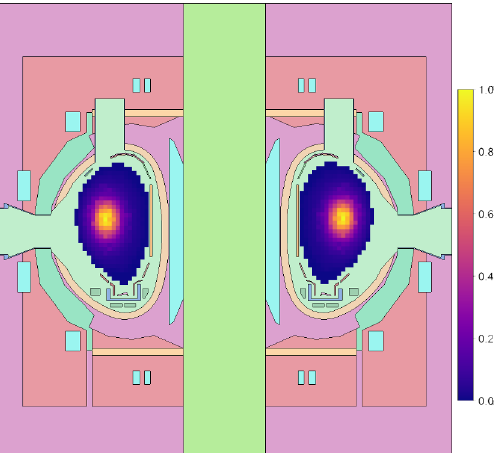
Figure 2: Sectional view of a realistic D shaped neutron source used for comparison between MCNP and Serpent. The highest neutron emission is in the centre of the plasma (yellow region) and is decreasing towards the plasma edge (blue